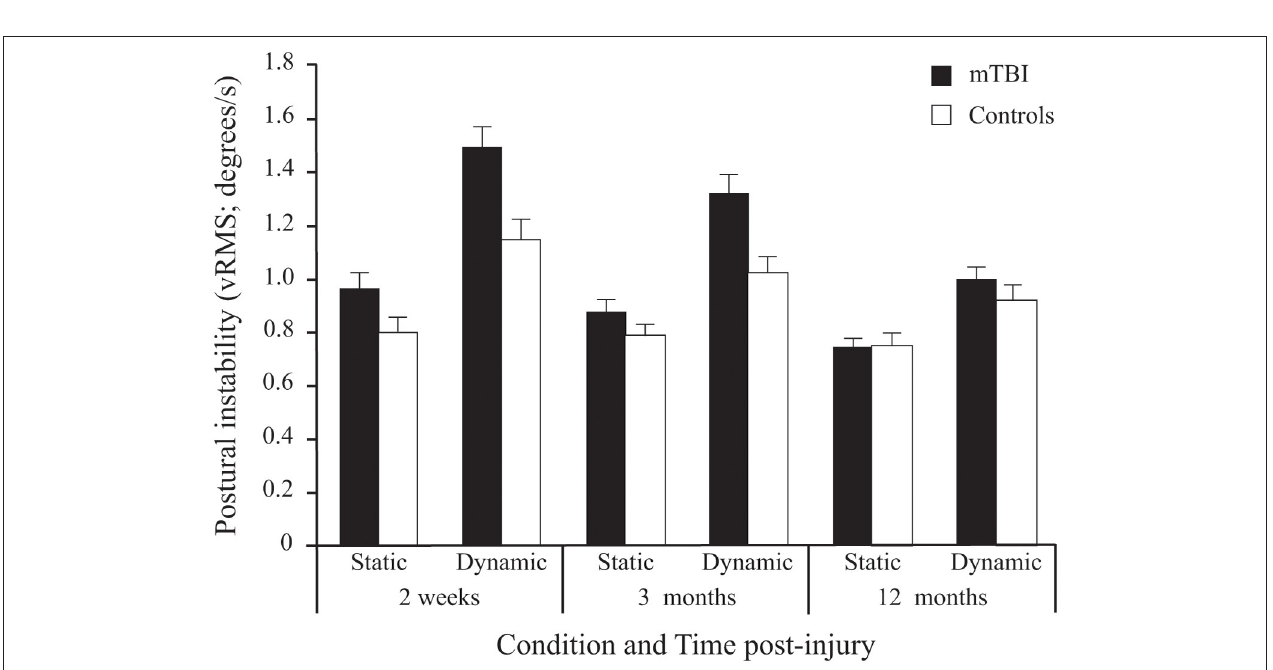
FIGURE 3 | Between-Group differences (Mean ± SEM mTBI vs. Mean ± SEM Controls) in Body Sway Amplitude (degrees) as a function of Condition and Time post-injury (Session). Note that since stimulus Frequency did not significantly influence inter-group differences, only average values of the three frequencies are shown here.